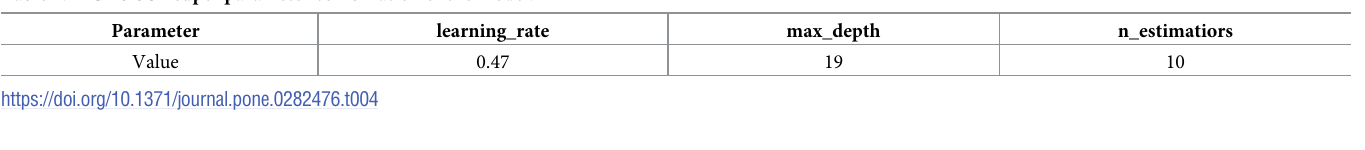
0.47, 19, and 10, respectively, the mean square error is the smallest, and the goodness of fit is the highest, and the model simulation can appear as the best prediction solution.